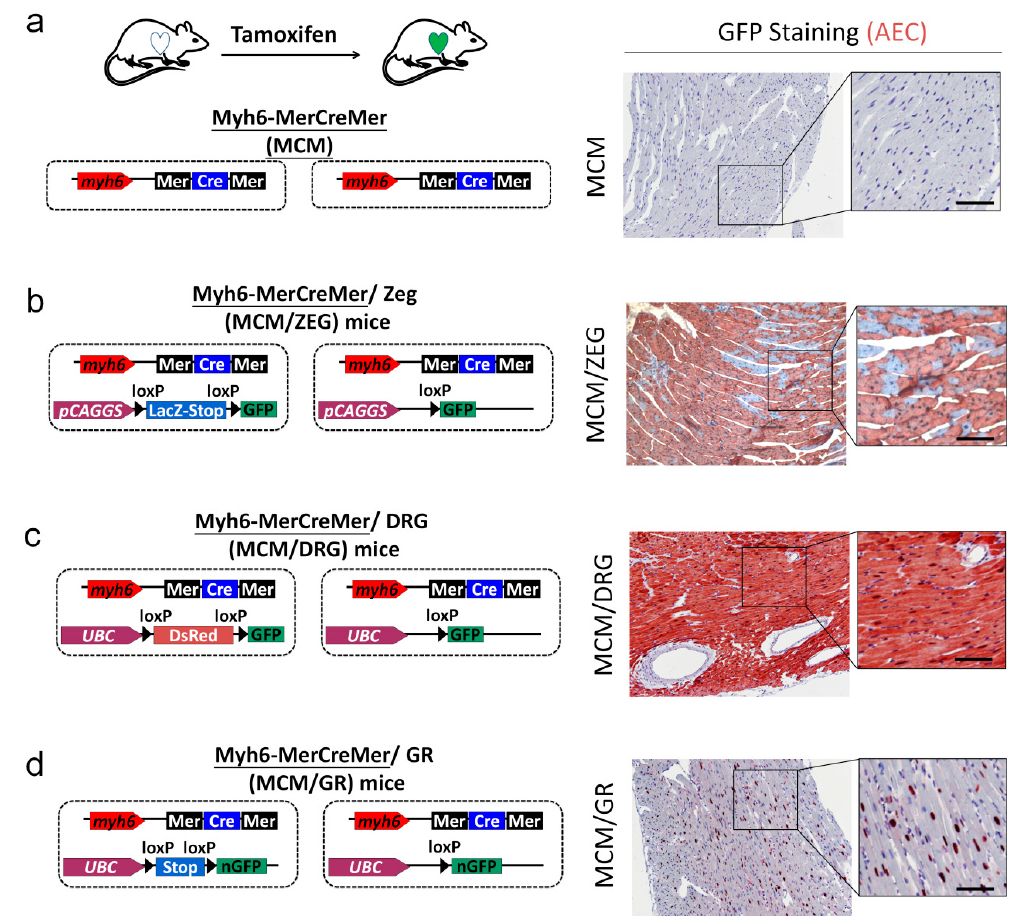
Figure 4. Generation of cardiomyocyte-specific reporter mouse models for genetic fate-mapping of adult cardiomyocytes. To establish a robust system for analyzing cardiomyocyte regeneration, we generated and compared the recombination efficiency of myh6-MerCreMer (MCM) mice with 3 different GFP reporter systems. GFP expression was detected by immunohistochemical staining in the cardiac tissues of MCM/reporter mice injected with Tamoxifen. ( a ) MCM mice without a GFP reporter were used as a negative control. ( b ) The myh6-MerCreMer strain was crossed with ZEG mice to create MCM/ZEG double heterozygous mice. Upon a Tamoxifen pulse, the reporter switches from β -galactosidase (encoded by lacZ ) to cytosolic GFP expression in cardiomyocytes only. ( c ) The myh6-MerCreMer strain was crossed with DRG mice to create MCM/DRG double heterozygous mice. Upon Tamoxifen’s pulse, the reporter switches from DsRed to cytosolic GFP expression in cardiomyocytes only. ( d ) The myh6-MerCreMer strain was crossed with GR mice to create MCM/GR double heterozygous mice. Upon a Tamoxifen pulse, the reporter switches from non-GFP expression to nuclear GFP expression in cardiomyocytes only. Bars represent 50 μ m.